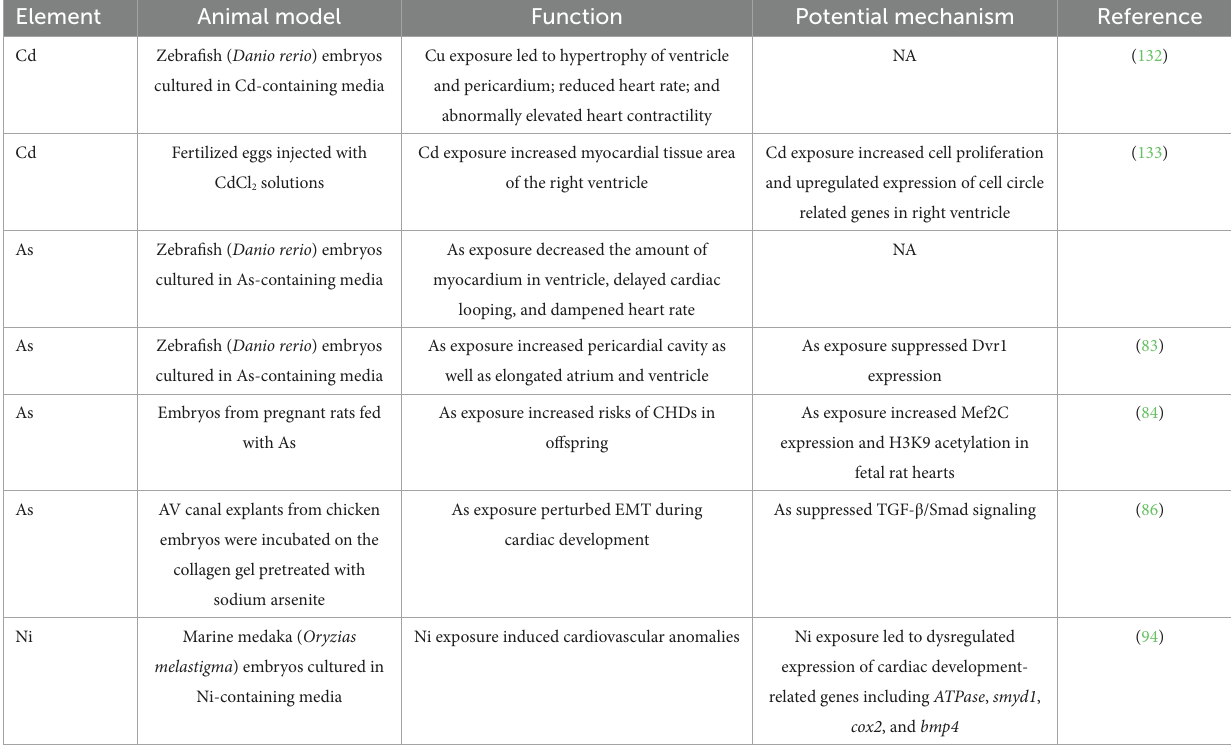
TABLE 4 Summary of laboratory-based studies reporting the relationship between nonessential trace element exposure and CHDs.